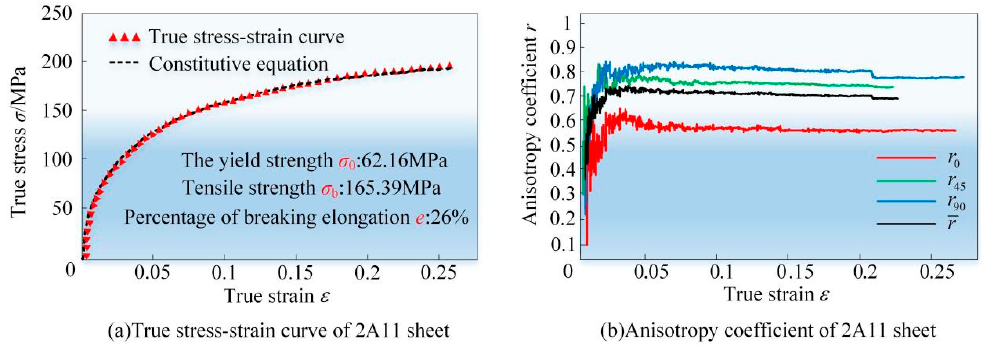
Figure 2. Uniaxial tensile test diagram of 2A11 aluminum alloy sheet: ( a ) test drawing machine diagram; ( b ) uniaxial tensile sample.